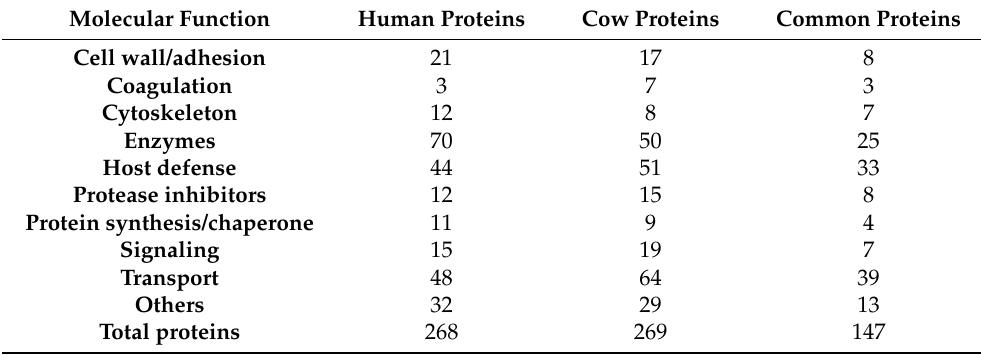
Table 2. Number of proteins in human and cow MFGM proteomes related to various molecular functions, listed according to the gene ontology (GO) annotation. Adapted from Hettinga et al. (2011) [27]. Molecular